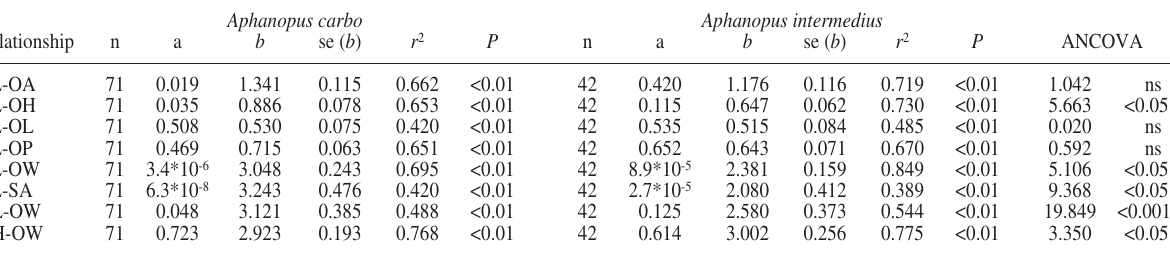
Table 2. – Regression parameters of the relationships by species and ANCOVA test comparing the slopes between species. CL, cephalic length; OA, otolith area; OH, otolith height; OL, otolith length; OP, otolith perimeter; OW, otolith weight; SA, sulcus area.